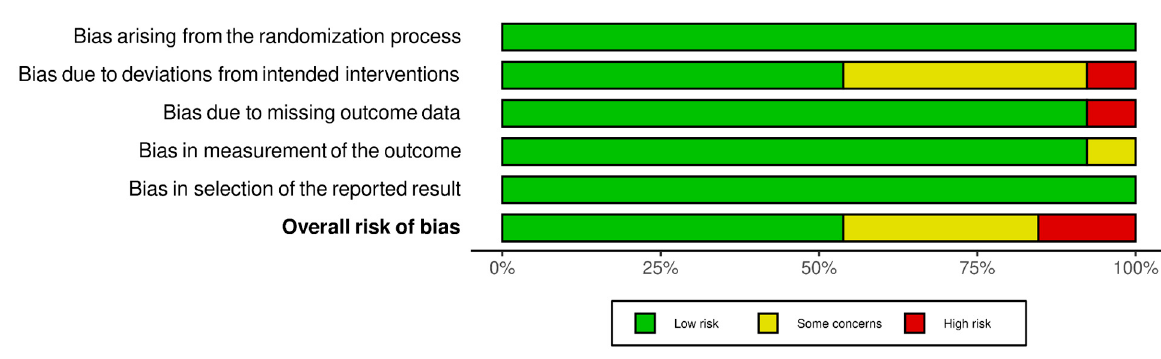
Figure 3. Summary risk of bias.